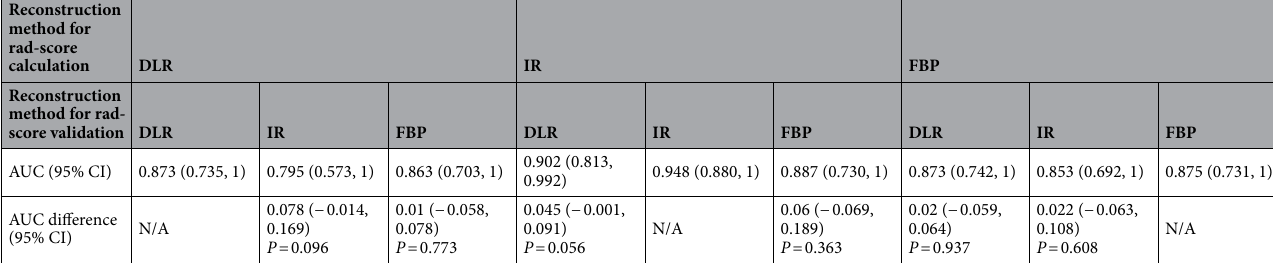
Table 3. Validating radiomics scores calculated with one reconstruction method in other reconstruction methods. Rad-score, radiomics score; DLR, deep learning-based reconstruction; IR, iterative reconstruction; FBP, filtered back projection; AUC, area under the receiver operating characteristic curve; CI, confidence interval; N/A,